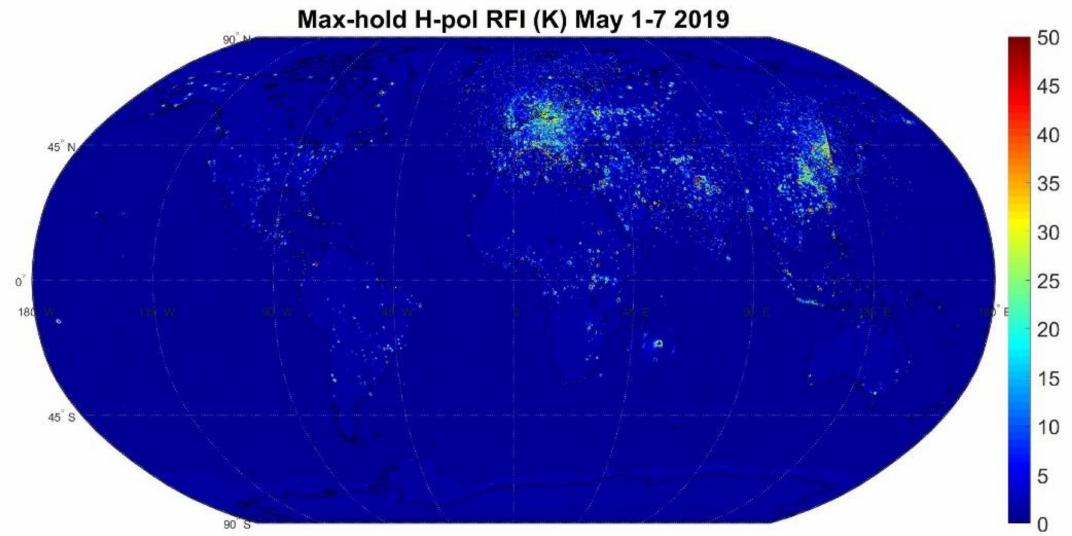
Figure 2. Max-hold H-pol RFI amplitudes, i.e., the difference between brightness temperatures before and after RFI mitigation, between 1 and 7 May 2019. The results demonstrate significant RFI presence in the protected portion of L-band, especially over Europe and Eastern